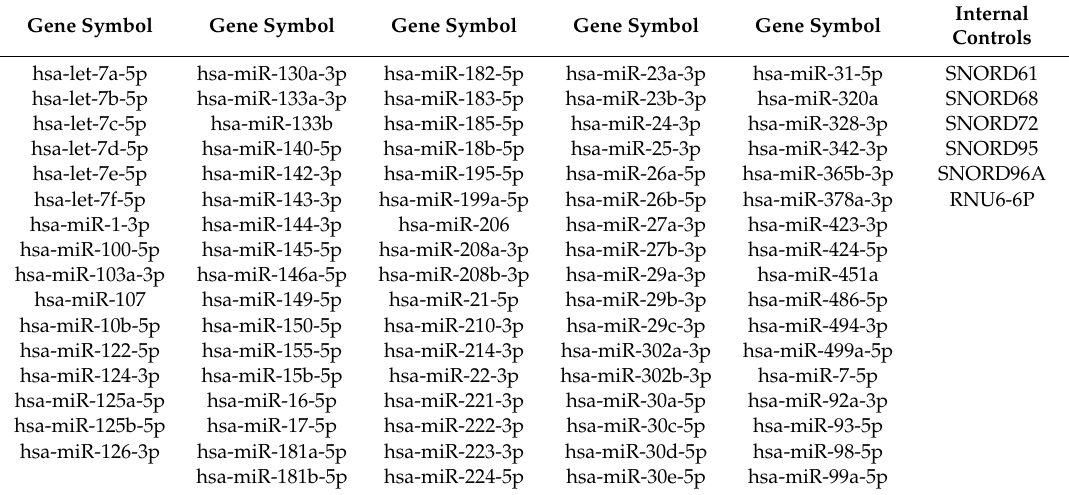
Table 1. List of MiRNA Array